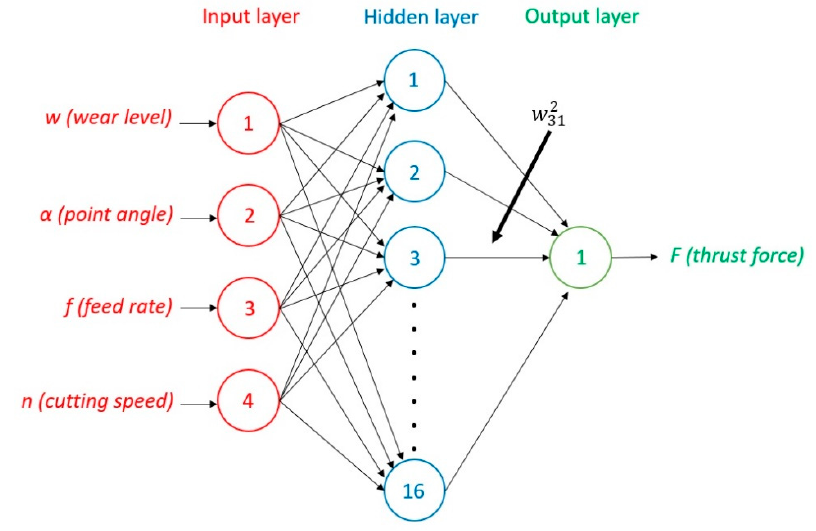
Figure 2. Architecture of the ANN with three layers implemented.